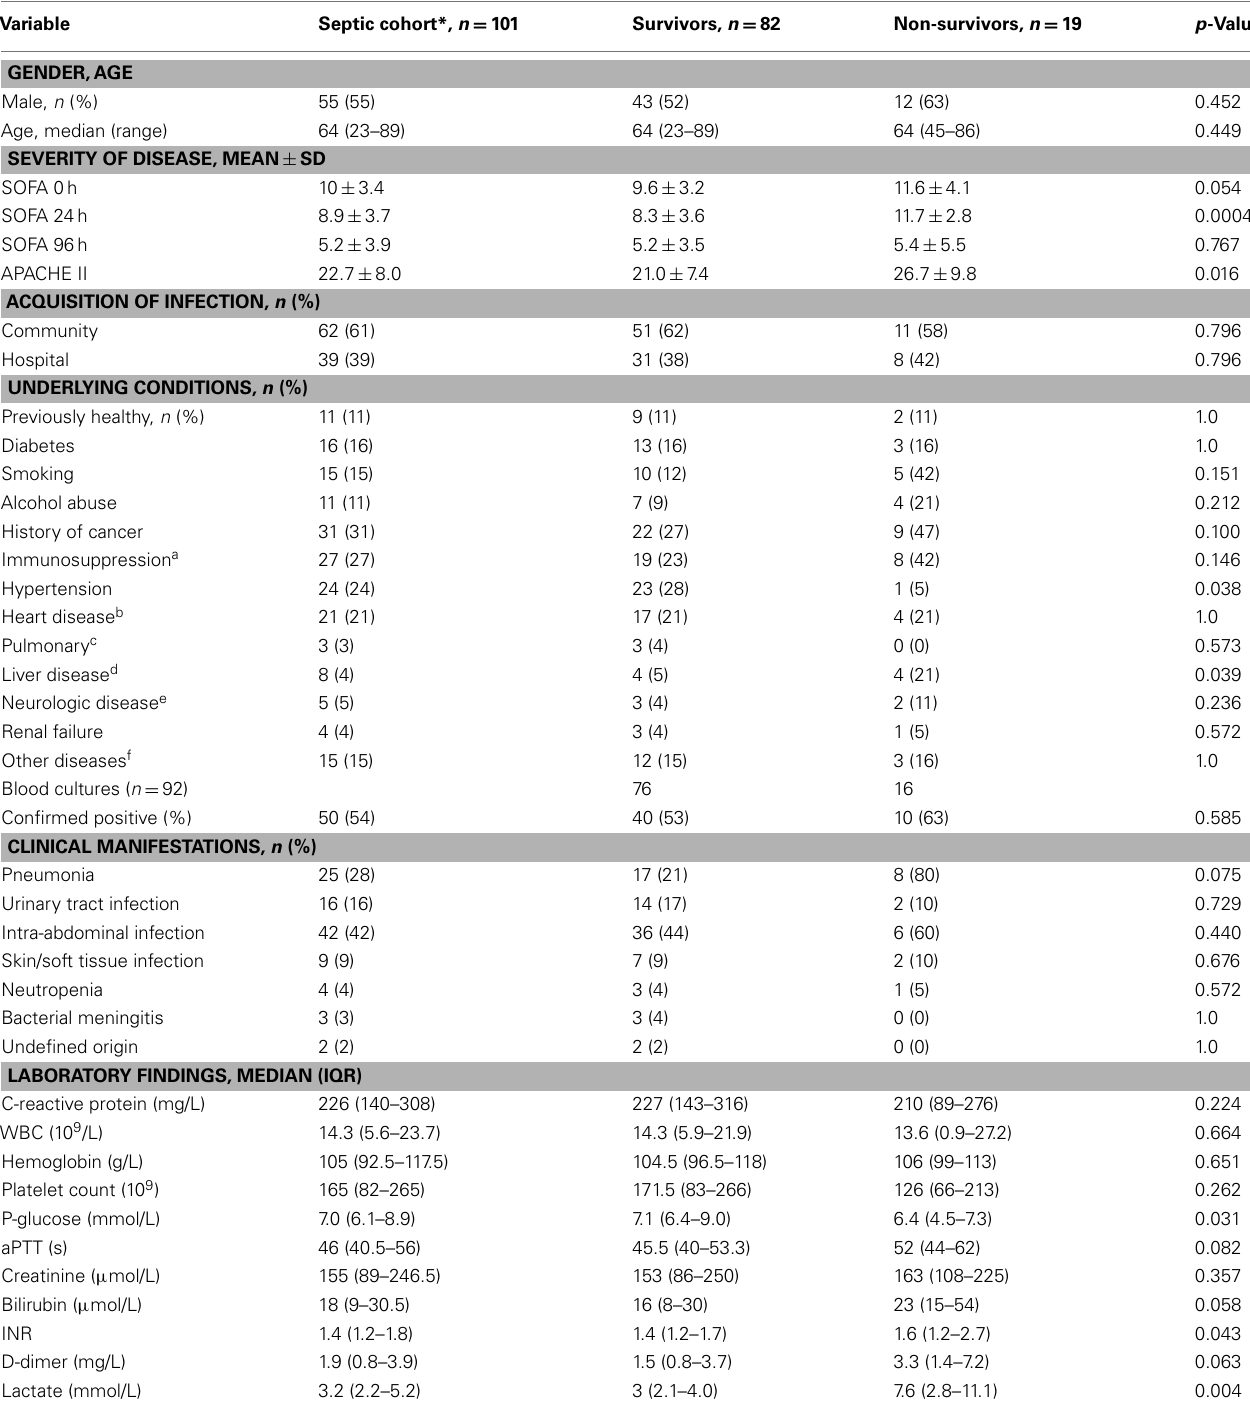
Table 1 | Baseline patient characteristics and laboratory findings in total cohort, and survivors vs. non-survivors